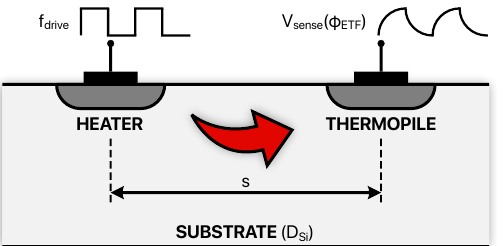
Figure 9. Electrothermal filter for thermal diffusivity